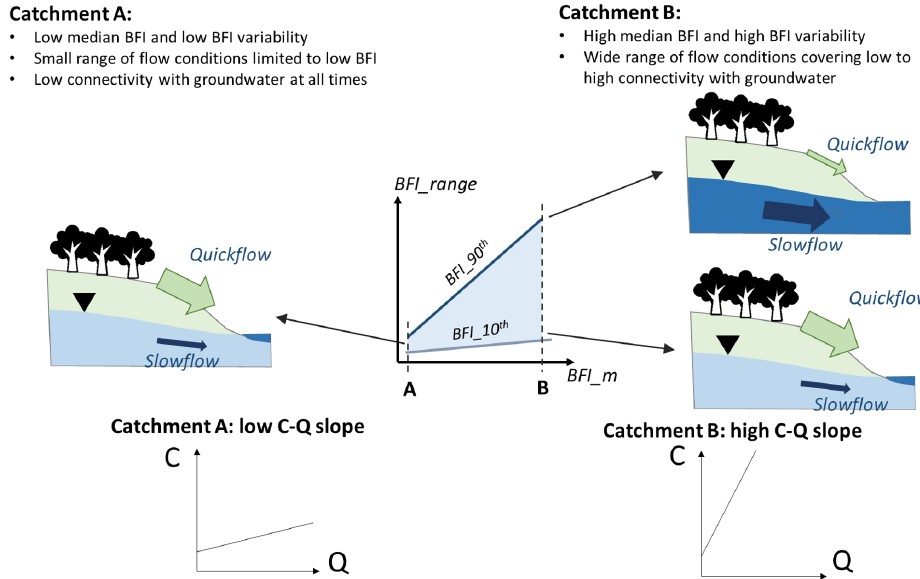
Figure 7. Conceptual diagram of the expected hydrological conditions in catchments with low and high median and variability in baseflow contribution (BFI_m and BFI_range), as Catchments A and B, respectively. The contrasting hydrological conditions can help explain our modelled results of the impacts of baseflow contributions on C – Q slopes. Note that the C – Q intercepts in the plots are not indicative since we do not investigate the variation in C – Q intercepts in this